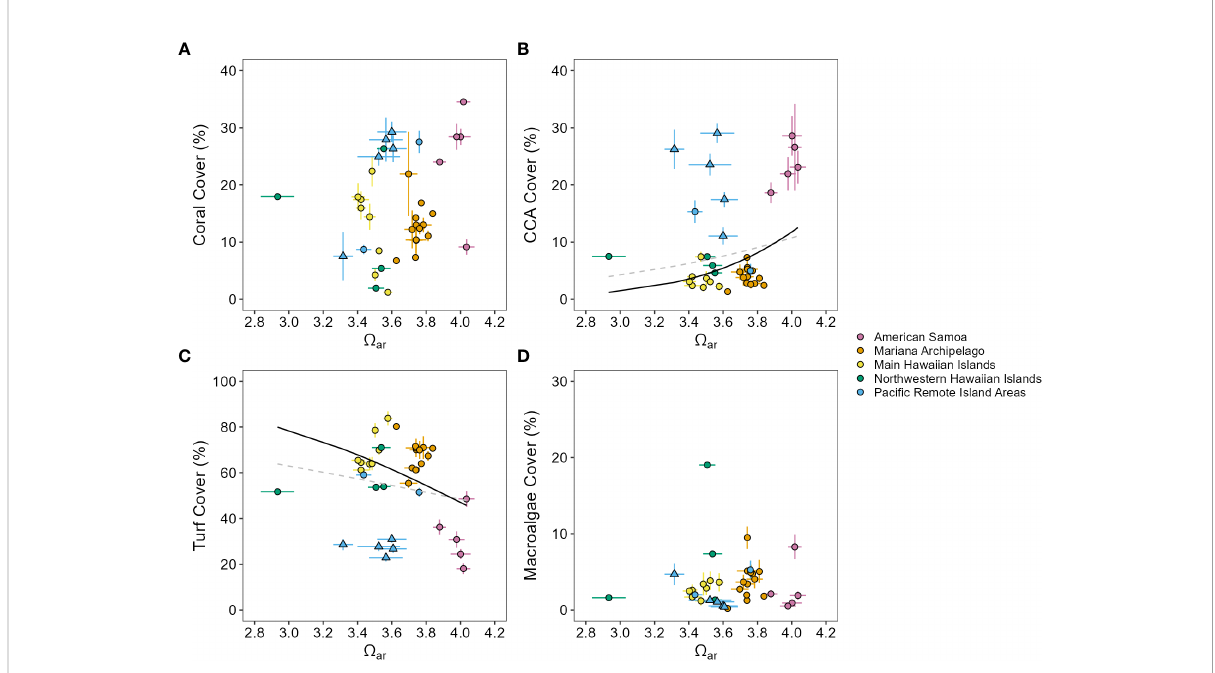
FIGURE 3 Benthic community responses across a Paci fi c-wide gradient in W ar . Mean (± standard error) percent cover of (A) hard coral, (B) crustose coralline algae (CCA), (C) turf, and (D) macroalgae plotted against mean (± standard error) W ar for each island (2010 – 2019 means). (B, C) Gray dashed lines show non-signi fi cant beta regression model fi t for all data, and black lines show signi fi cant (solid, p ≤ 0.05) and non-signi fi cant (dashed, p > 0.05) beta regression model fi t with equatorial and near-equatorial Paci fi c Remote Island Areas (triangles) removed; neither fi t was signi fi cant for (A, D)